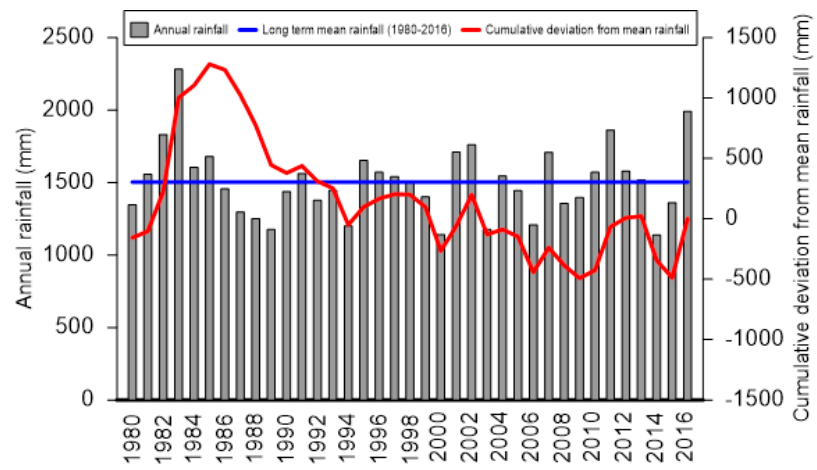
Figure 3. Annual rainfall from 1980 to 2016 for the Center for Water Resources and Environmental Studies (CRHEA) station.